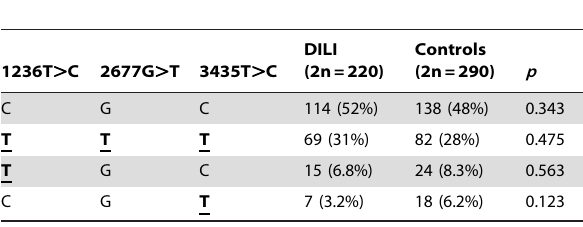
Table 4. Predicted haplotype frequencies of transporter gene polymorphisms.